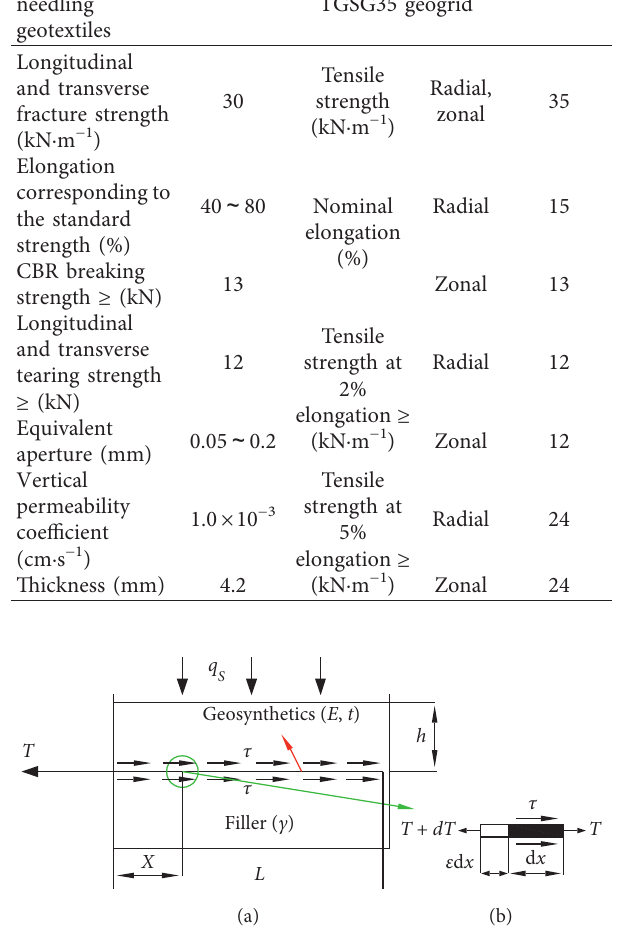
Figure 4: Pull-out sketch of the reinforcement: (a) overall stress of reinforcement and (b) force analysis of the microelement of